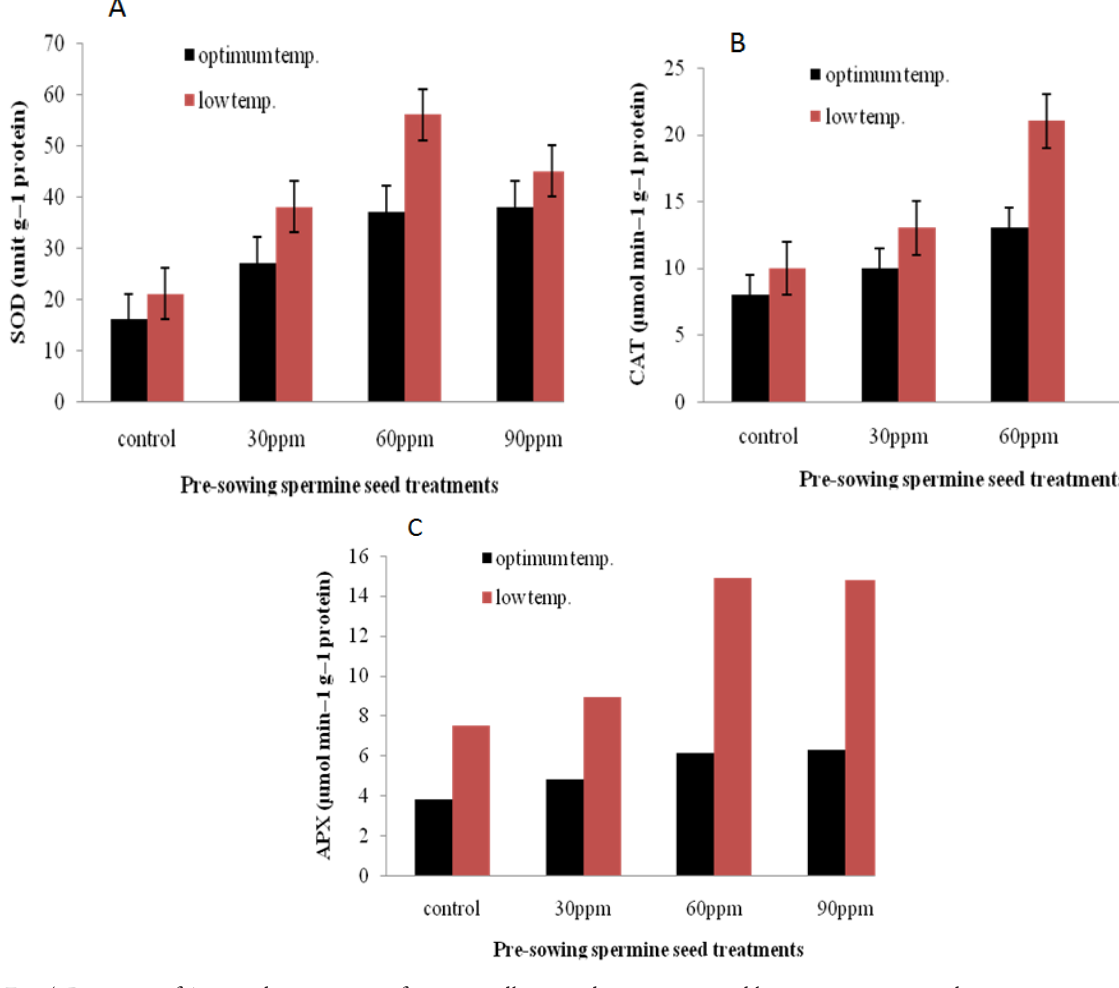
Fig. 4. Response of Antioxidative system of maize seedlings under optimum and low temperature conditions to spermine applica- tion including Superoxide dismutase (SOD) (A), Catalaze (B) and Ascorbate Peroxidase (C). Data are the mean value of three replications ± SE which represented by the vertical bar in each